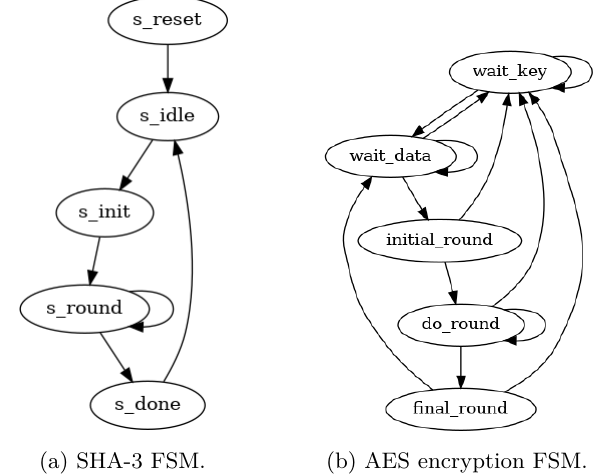
Figure 14: Original state transition graph diagrams of hardware designs utilized in Section